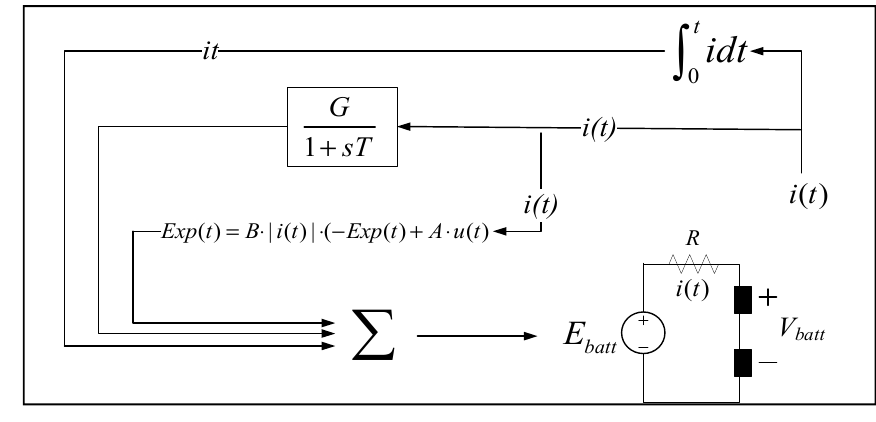
Figure 10. Discharge Ni-MH battery model.